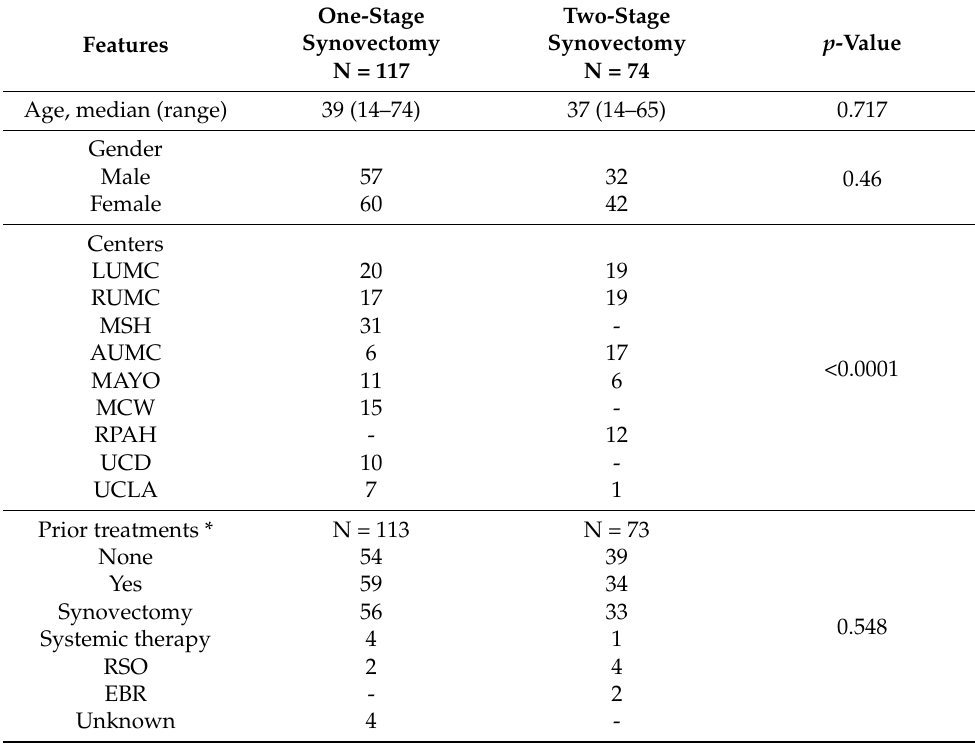
Table 1. D-TGCT patient baseline